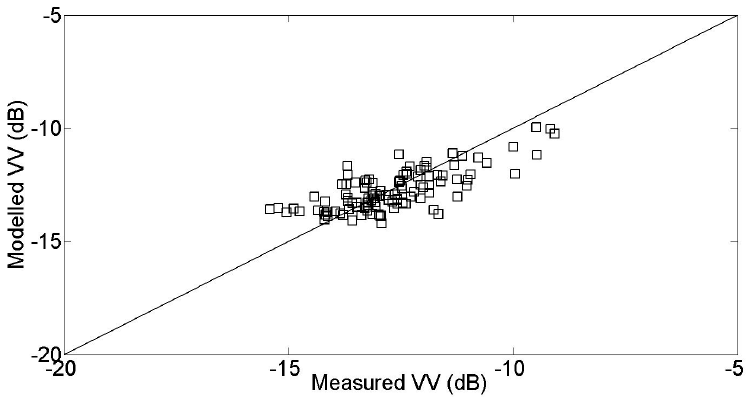
Figure 11. Water cloud model validation for the VV polarization.